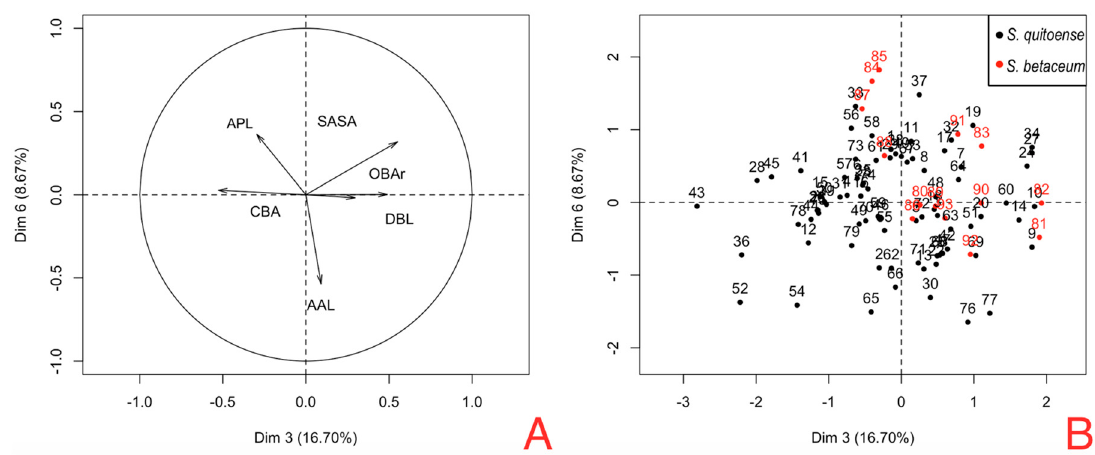
Figure 7. Principal component analysis; ( A ) Biplot of PC3 and PC6; ( B ) PCA plot components in the classification of N. elegantalis females hosted in two Solanaceae families ( S. quitoense and S. betaceum ).